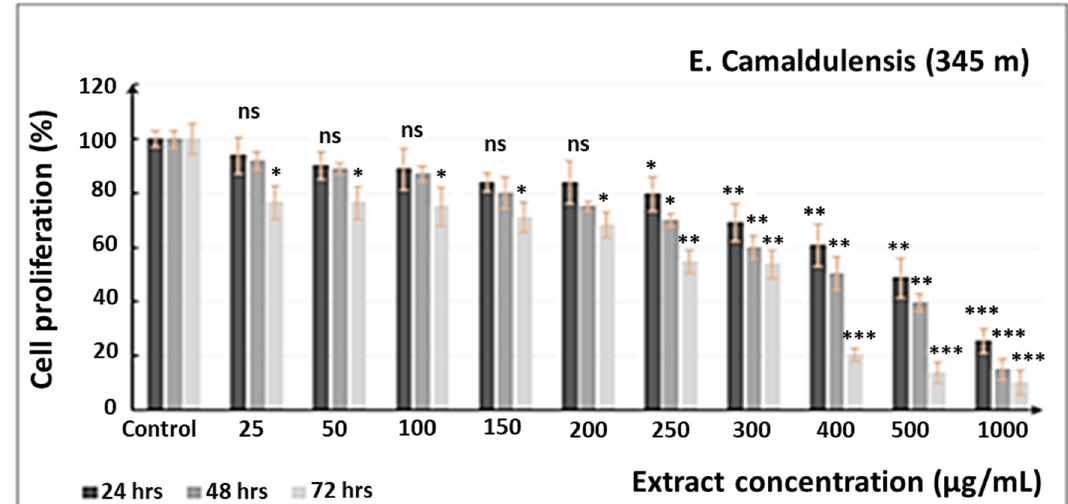
Figure 3. Cell proliferation of A549 cells after the exposure to the aqueous extract of E. camaldulensis (345 m) for 24, 48, and 72 h. Peak values are represented as mean +/ − SD. Statistical analysis: Paired t test or Wilcoxon test. * p < 0.05; ** p < 0.01; *** p < 0.001 in which percentage of proliferation of treated cells is compared with that of control at 24, 48, or 72 h. ns refers to non-significant result.